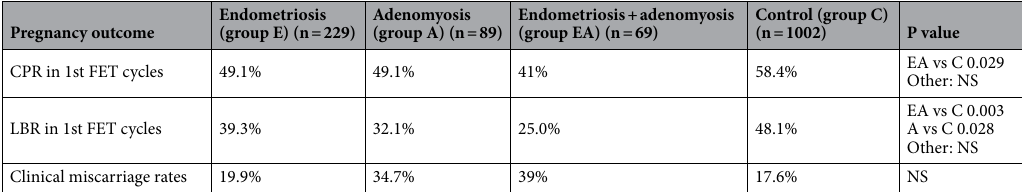
Pregnancy outcome